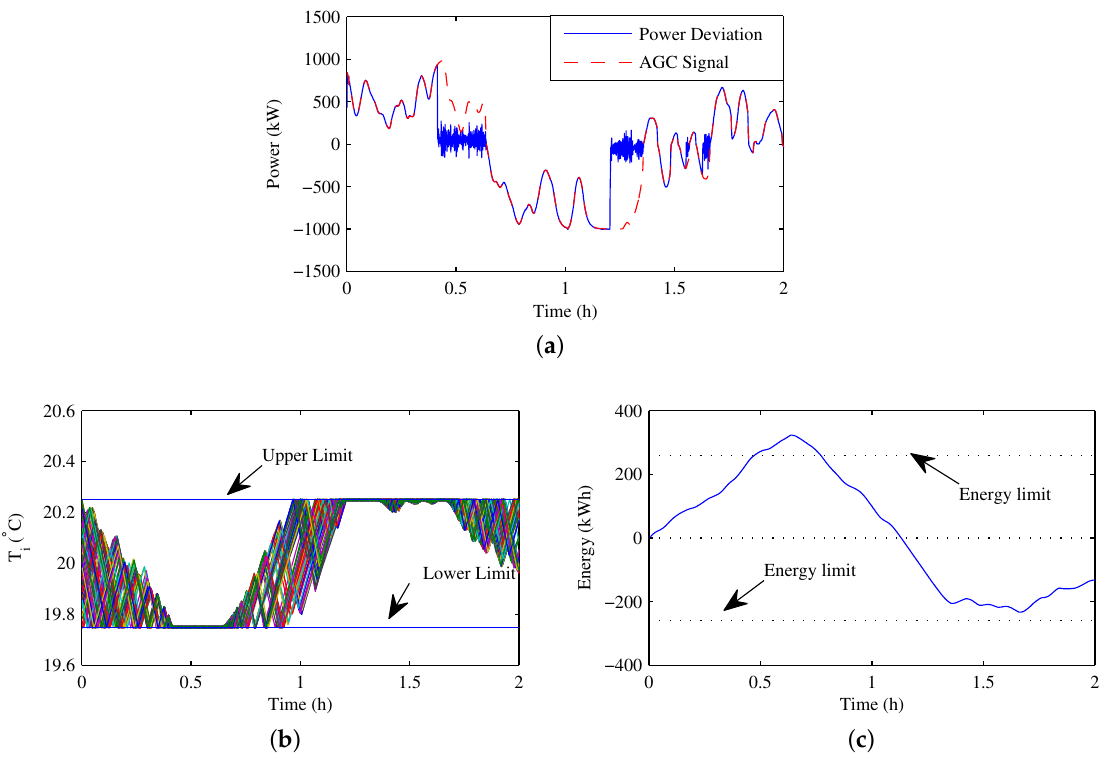
Figure 1. ( a ) AGC signal tracking under the temperature priority control strategy; ( b ) Temperature distribution of 100 HVAC units (randomly chosen out of 1000) and ( c ) State of charge.